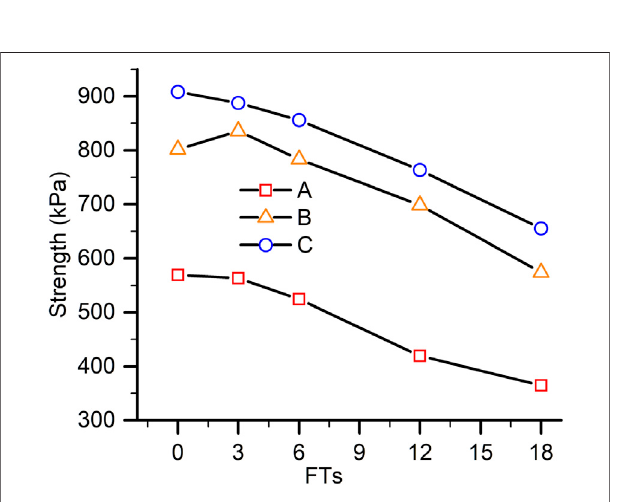
FIGURE 4 | UCSs of S/S sediments in FTs.